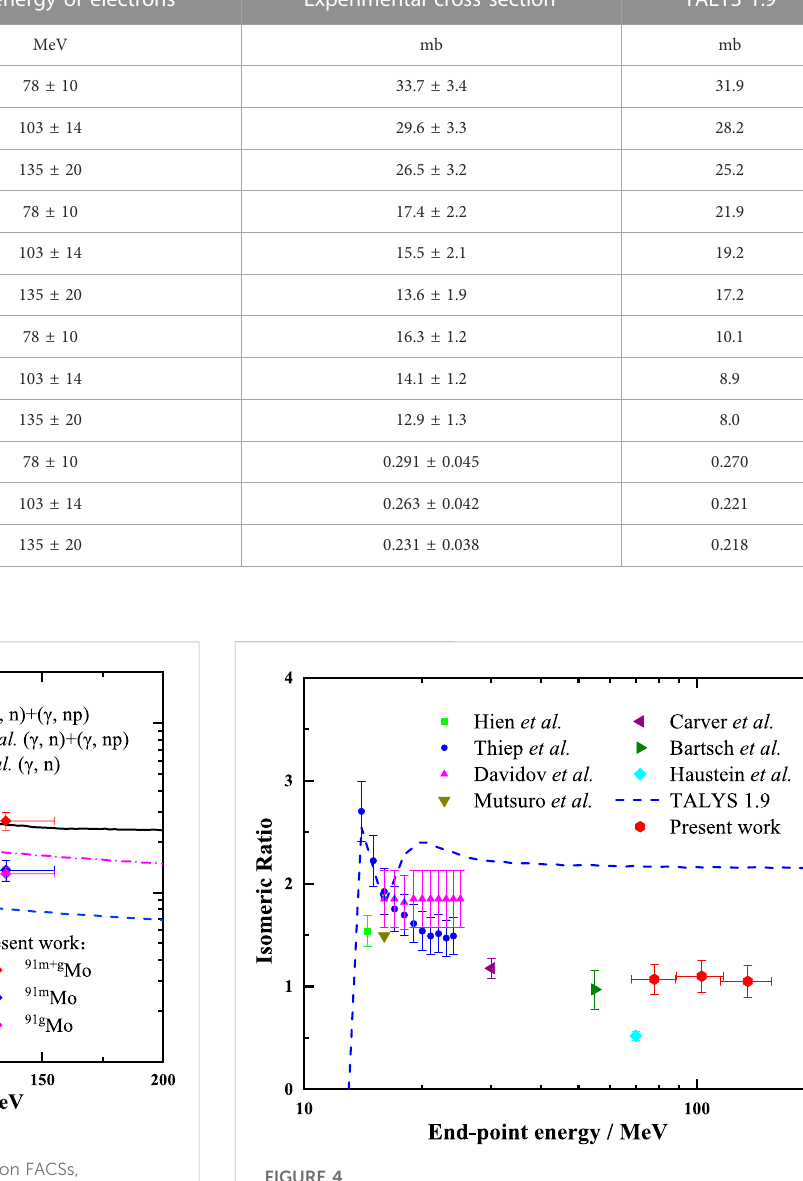
TABLE 2 Experimental fl ux-weighted average cross sections of 92 Mo( γ , n) and ( γ , 3n) reactions determined by present work and theoretical values of TALYS 1.9 calculated using a monoenergetic electron beam with the energies of 78, 103 and 135 MeV. Reaction Center energy of electrons Experimental cross section TALYS 1.9